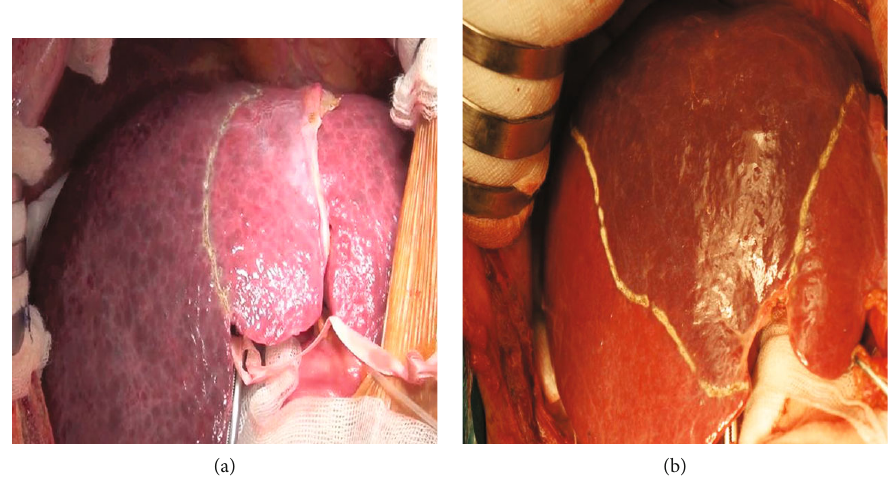
Figure 6: (a) Transection line of right liver; (b) transection line of anterior section.